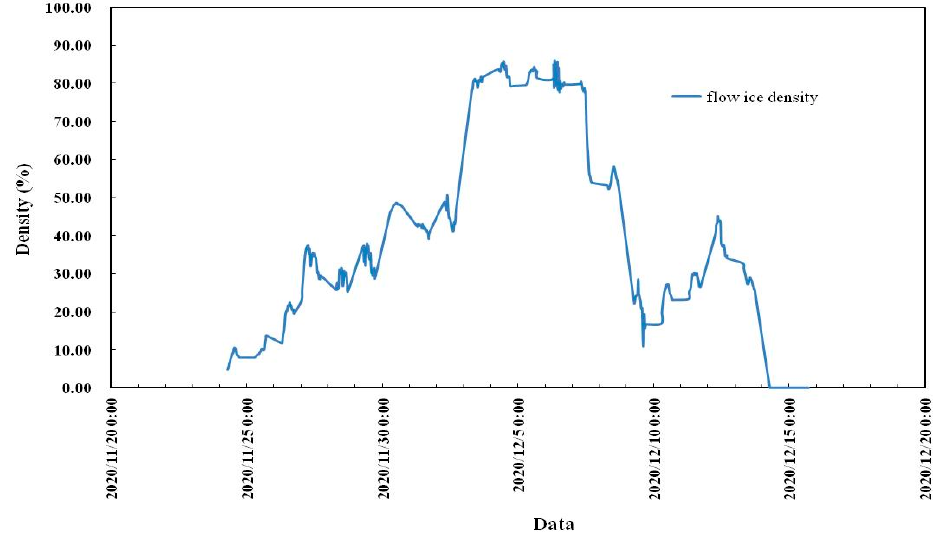
Figure 8. Flow ice density of the Shisifenzi reach in the 2020–2021 ice period.